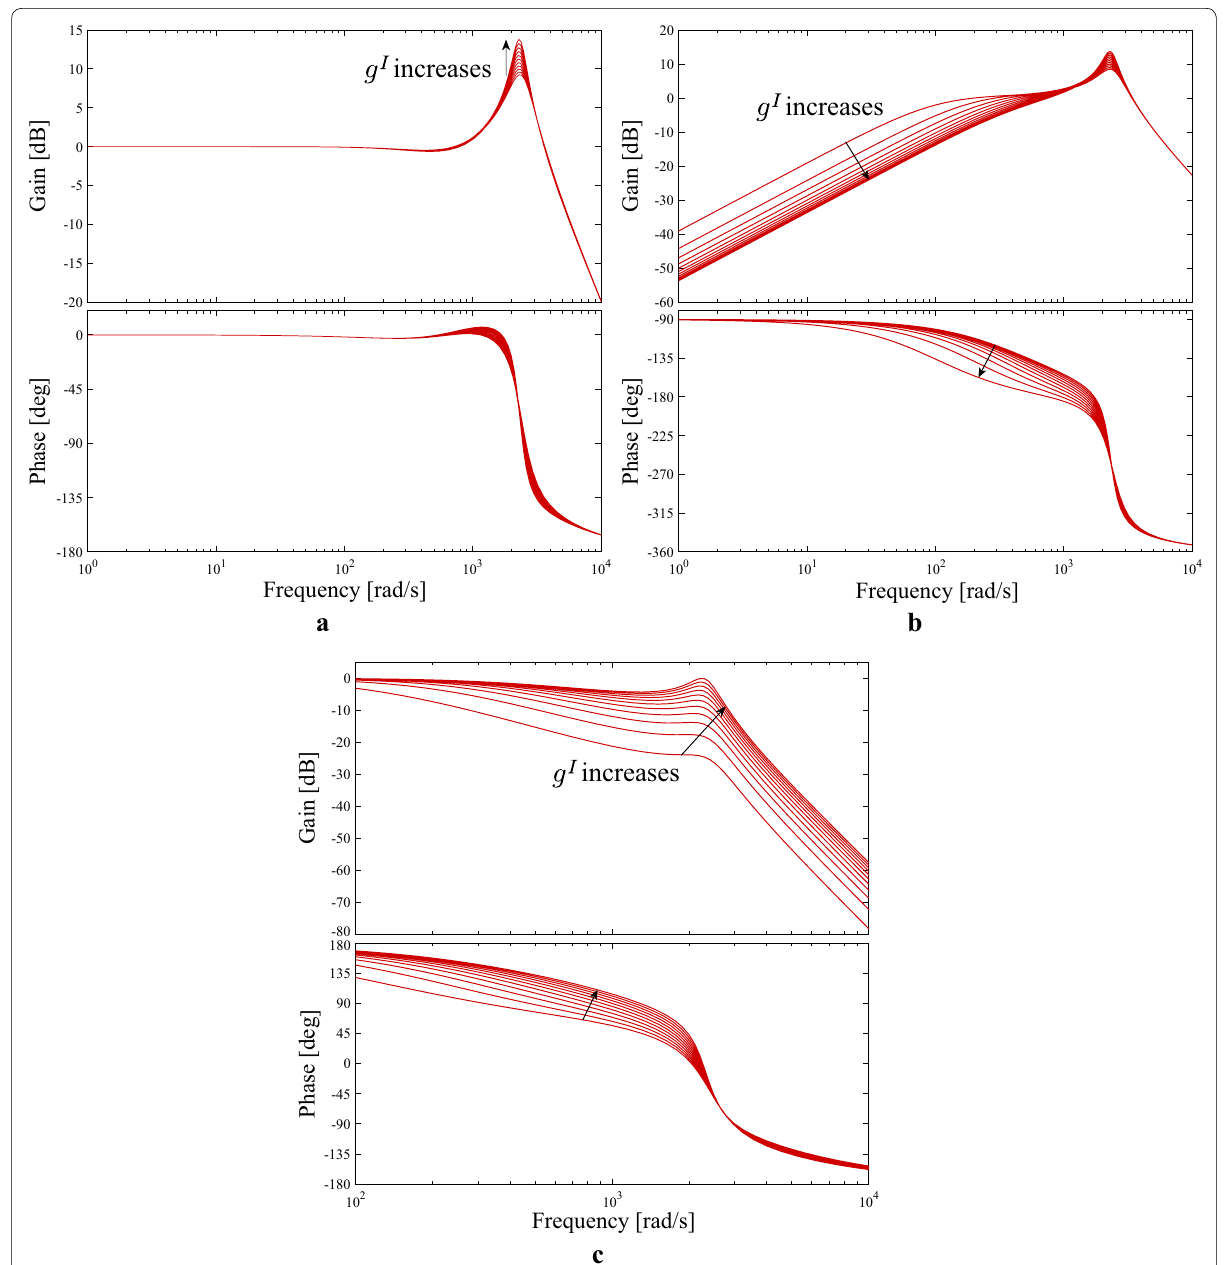
Fig. 9 Bode diagram of transfer functions with the variation of the bandwidth of sensor and RTOB integration g I from 100 to 1100 rad/s. a Transfer functions from command torque to output external torque. b Transfer functions from load torque to output external torque. c Transfer functions from sensor noise to output external